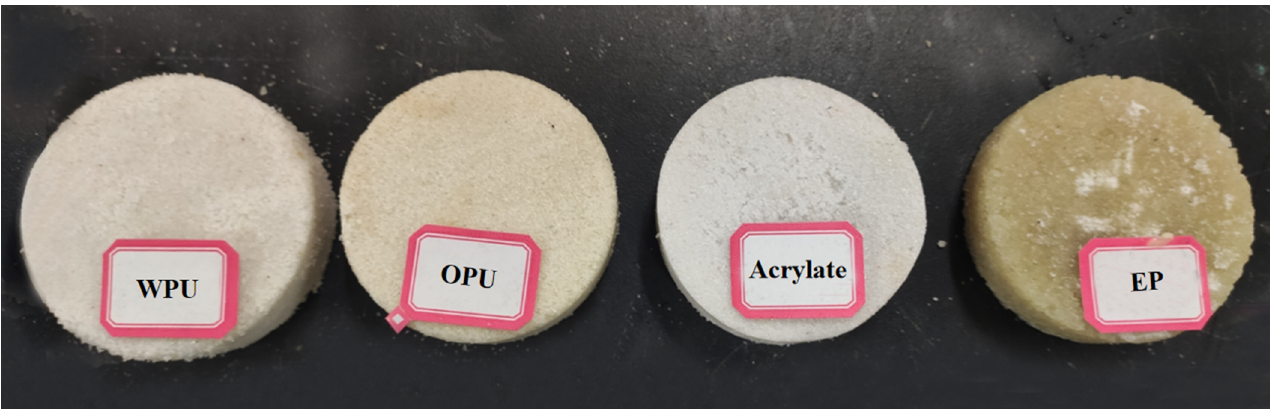
Figure 1. Chemical grouted sands impermeability test specimens.